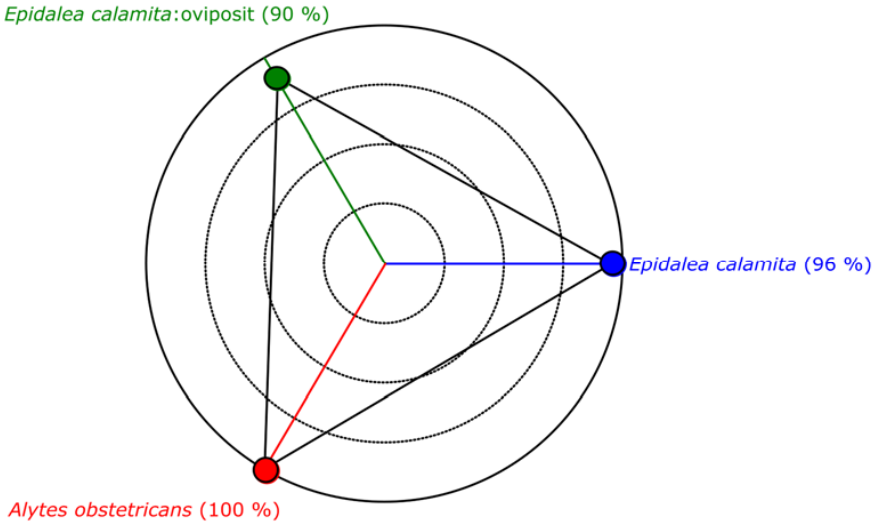
Figure 17. Performance of the modified maximum likelihood classifier.